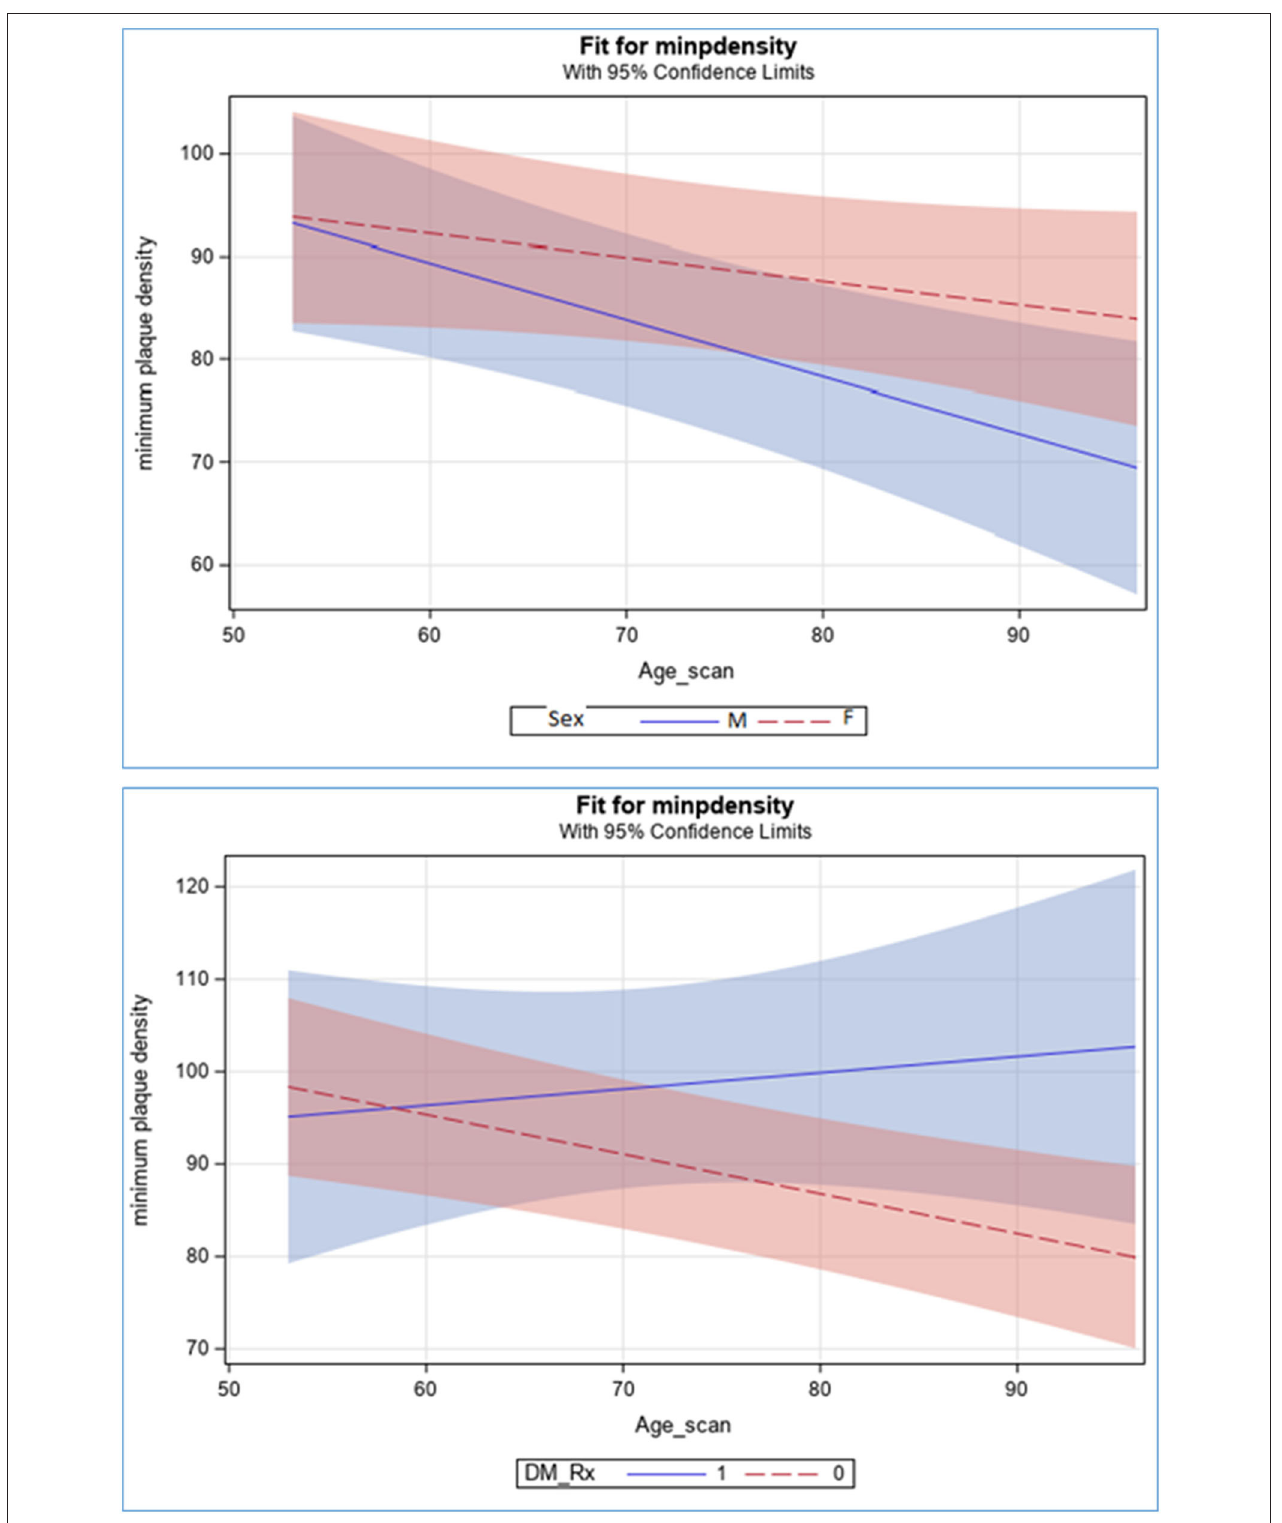
FIGURE 1 | Effect of age on minGSM by sex and antidiabetic medications.